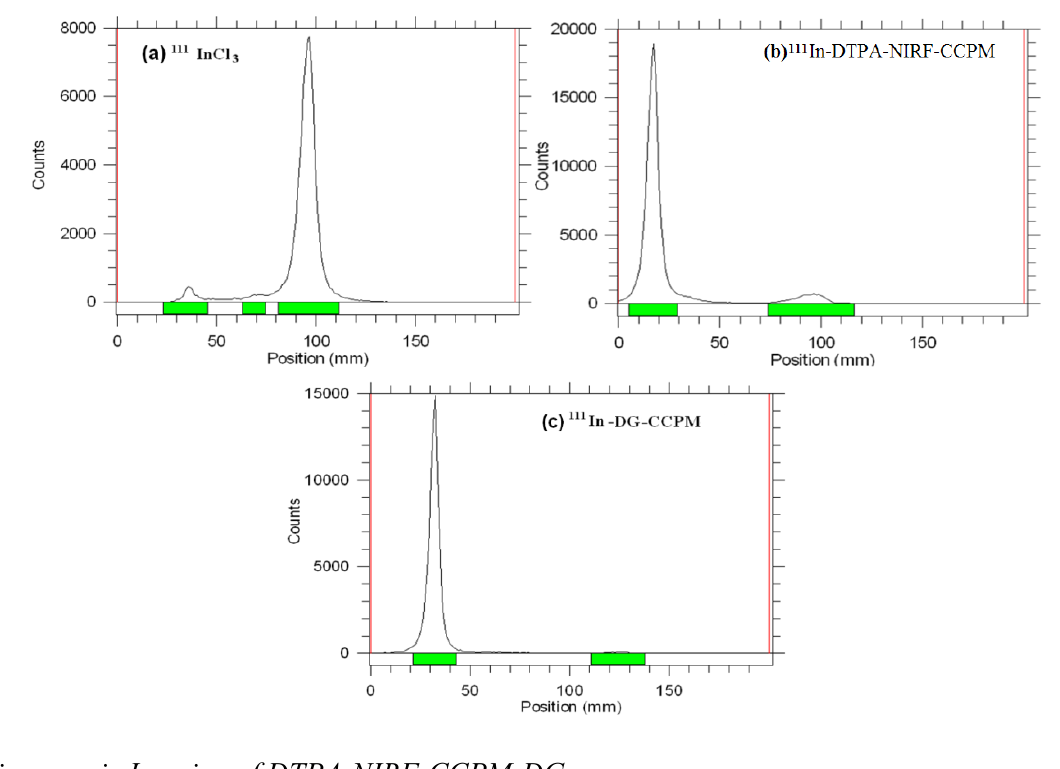
Figure 2. Radio-TLC analyses of ( a ) 111 InCl